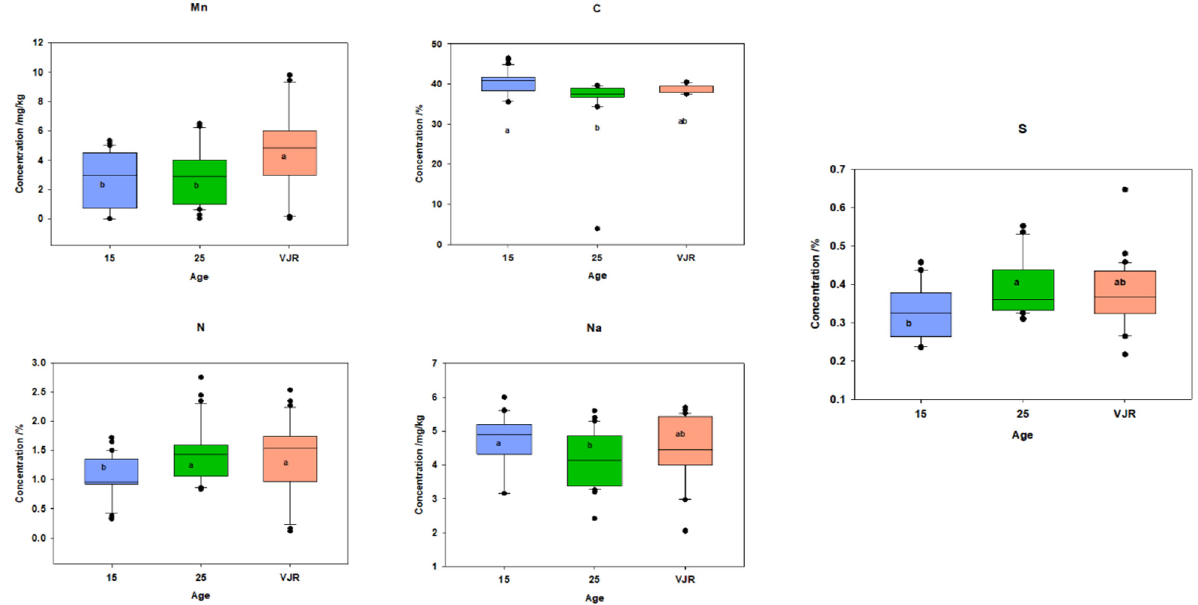
Figure 4. Elemental concentration in leaves (mean was taken for the same age compartments) in boxplot representation with the median, interquartile range, and outliers (black dots). Small letters (a, b, c) show different significance groups where the significance level was set as p < 0.05.